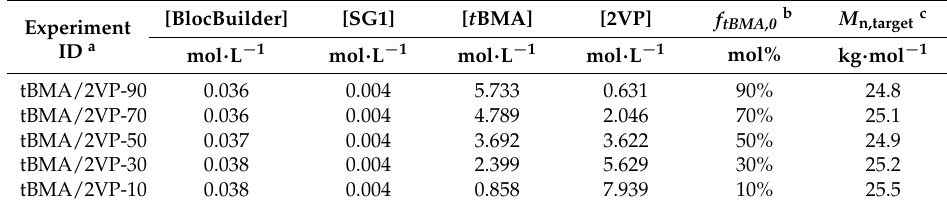
Table 1. Experimental conditions for the tert -butyl methacrylate/2-vinylpyridine t BMA/2VP statistical copolymerizations via nitroxide mediated polymerization (NMP) at 100 ◦ C in bulk. Experiment ID